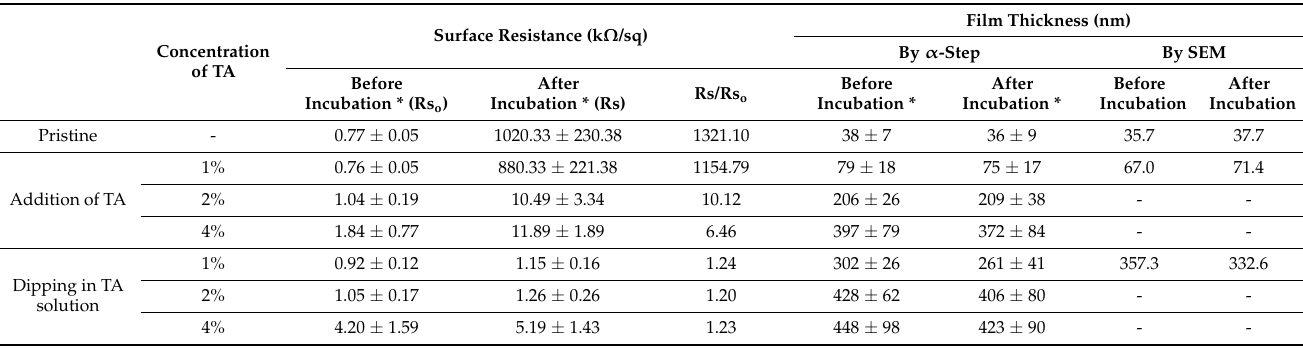
Table 1. Surface resistance and thickness of PEDOT:PSS films treated with TA before and after incubation at 150 ◦ C for 96